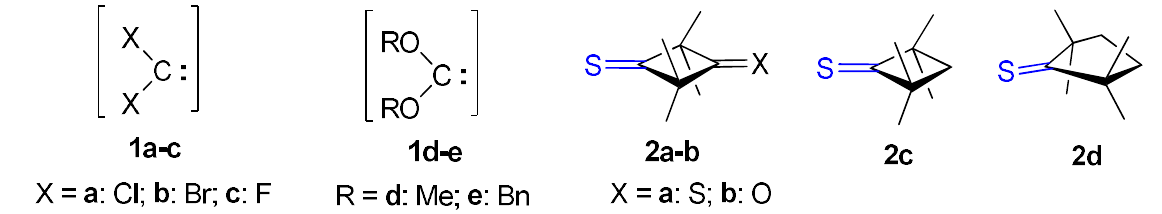
Figure 1. Dihalocarbenes, dialkoxycarbenes, and non-enolizable, cycloaliphatic thioketones 2a – d involved in the study.